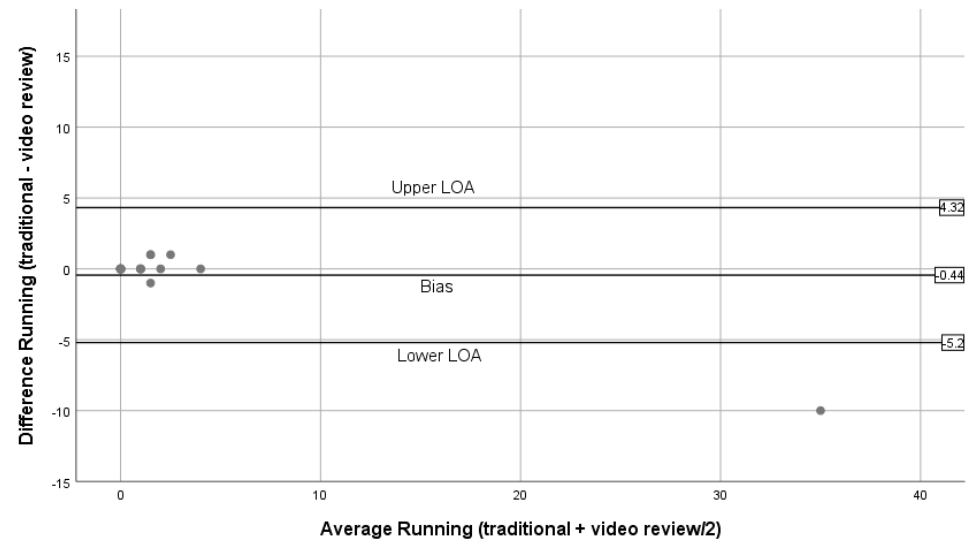
Figure 6. Bland–Altman plots for running (traditional BWM vs. expert review of BWM videos) .